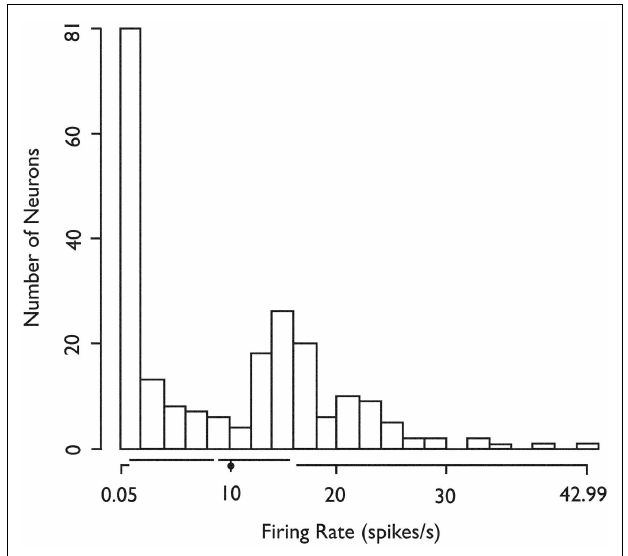
FIGURE 1 | Histogram of the in situ firing rates of all 222 (HH) neurons . X -axis. Limits of axis show minimum and maximum firing rates. Offsets in axis line indicate first and third quartiles. Break in axis line indicates median. Gray dot indicates mean. In situ firing rates for HH neurons distribute into at least two classes (fast-firing and slow-firing units). Used with permission from Barrow Neurological Institute .